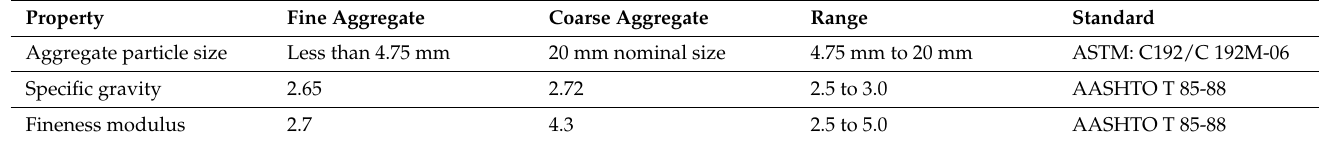
Table 3. Properties of Aggregates.